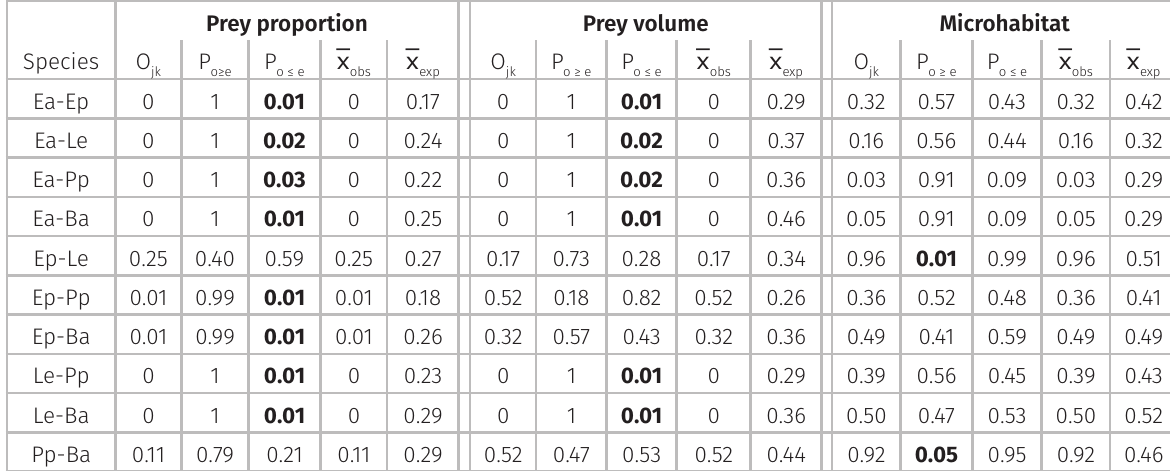
Table III. Pairwise interspecific relationships of species within the snake assemblage from the Sierras de Ventania in east-central Argentina. Overlap values of Pianka (1973) (O ), overlap significance (P ; P ), observed mean jk o ≥ e o ≤ e (  ) and expected mean (  ) of three traits: prey proportion, prey volume, and microhabitat use. Significant obs exp values (p ≤ 0.05) are shown in bold. See text for details of calculations. Other references as in Table I. Prey